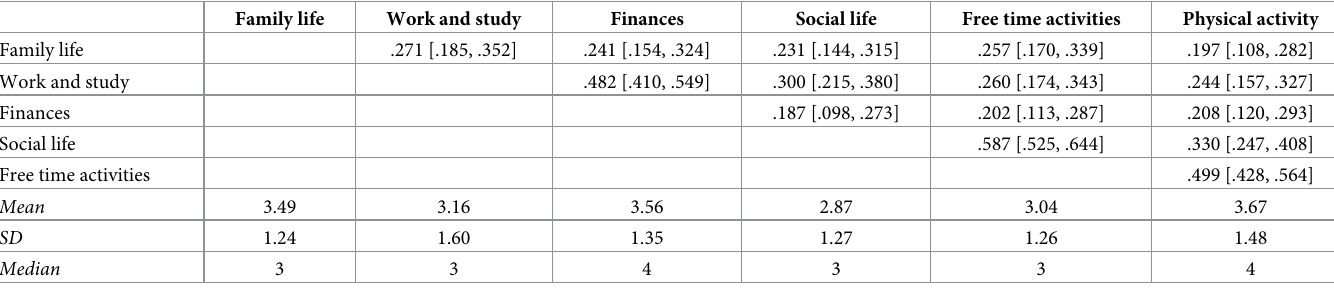
Table 2. Descriptive statistics and correlations between self-reported COVID-19